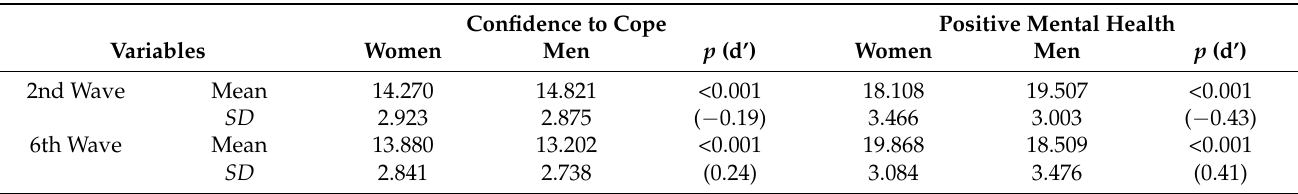
Table 1. Descriptive analysis on variables of interest across